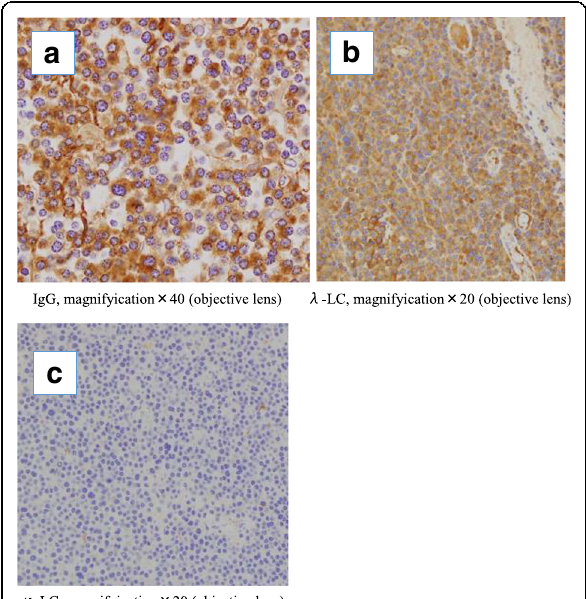
Fig. 4 Immunohistochemical examination. a , b In situ hybridization shows that most of the tumor expresses immunoglobulin G and lambda light chain mRNA. IgG, immunoglobulin G; λ -LC, lambda light chain. c In contrast, there is no expression of kappa light chain mRNA. κ -LC,